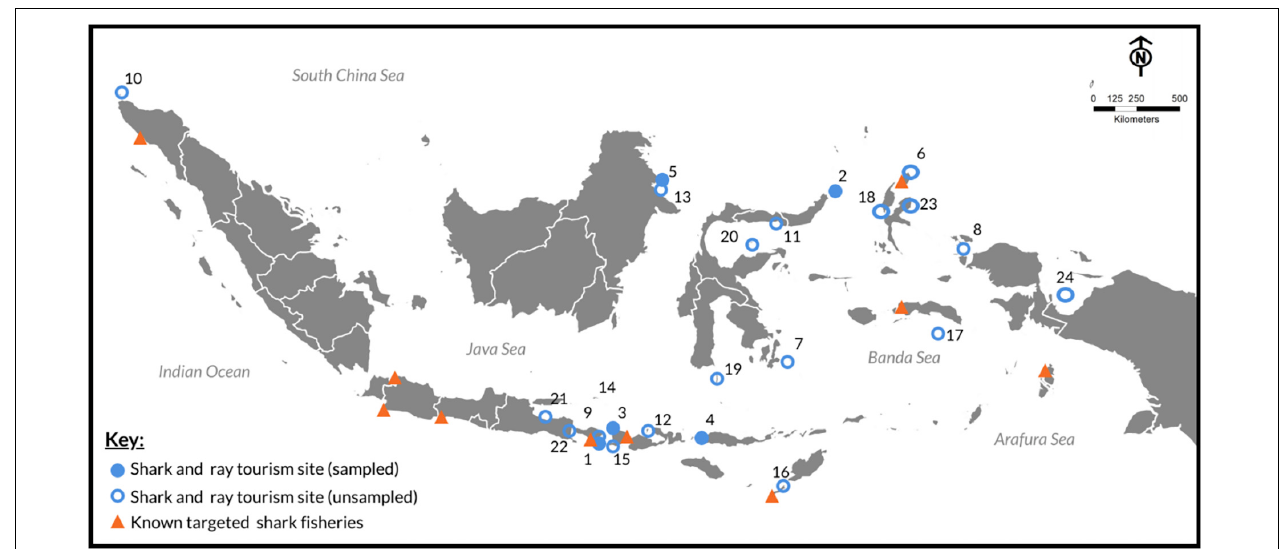
FIGURE 1 | Shark and ray tourism sites included in this study (numbers correspond to site names in Table 4A ) alongside known targeted shark fisheries based on published literature (Blaber et al., 2009; Fahmi and Dharmadi, 2015; Jaiteh et al.,